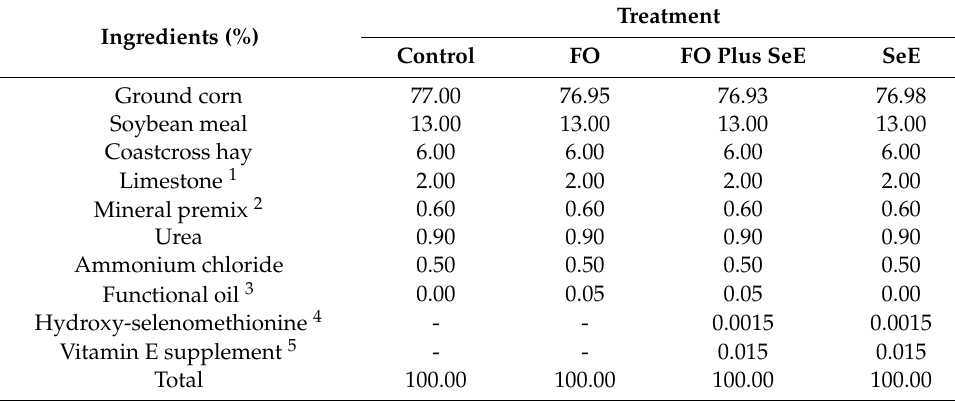
Table 1. Percent composition of the diets (dry matter